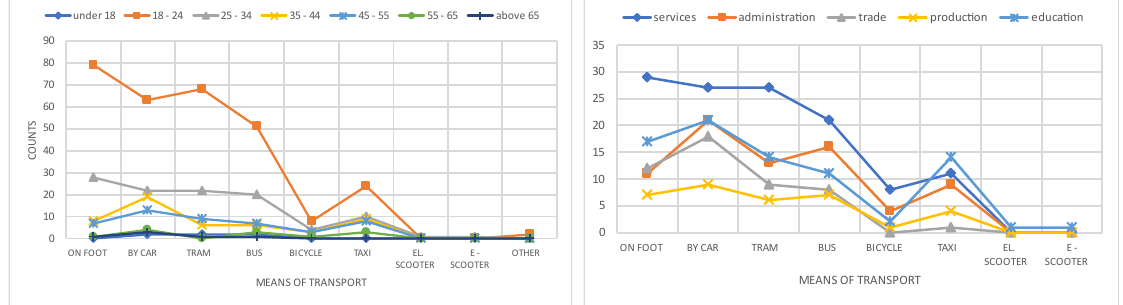
Figure 8. The choice of individual means of transport by users in the home – entertainment direction.